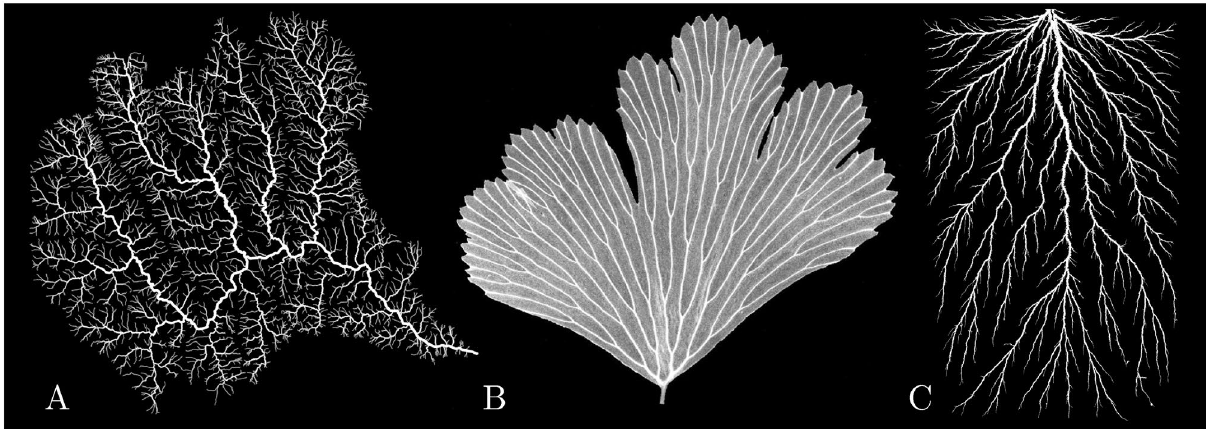
Figure 1. Examples of branched spatial networks in nature: ( A ) White River basin in Vermont, USA 7 ( B ) Adiantum leaf (photo: Jim Mattsson, Simon Fraser University, by permission) ( C ) Lichtenberg figure 8 .